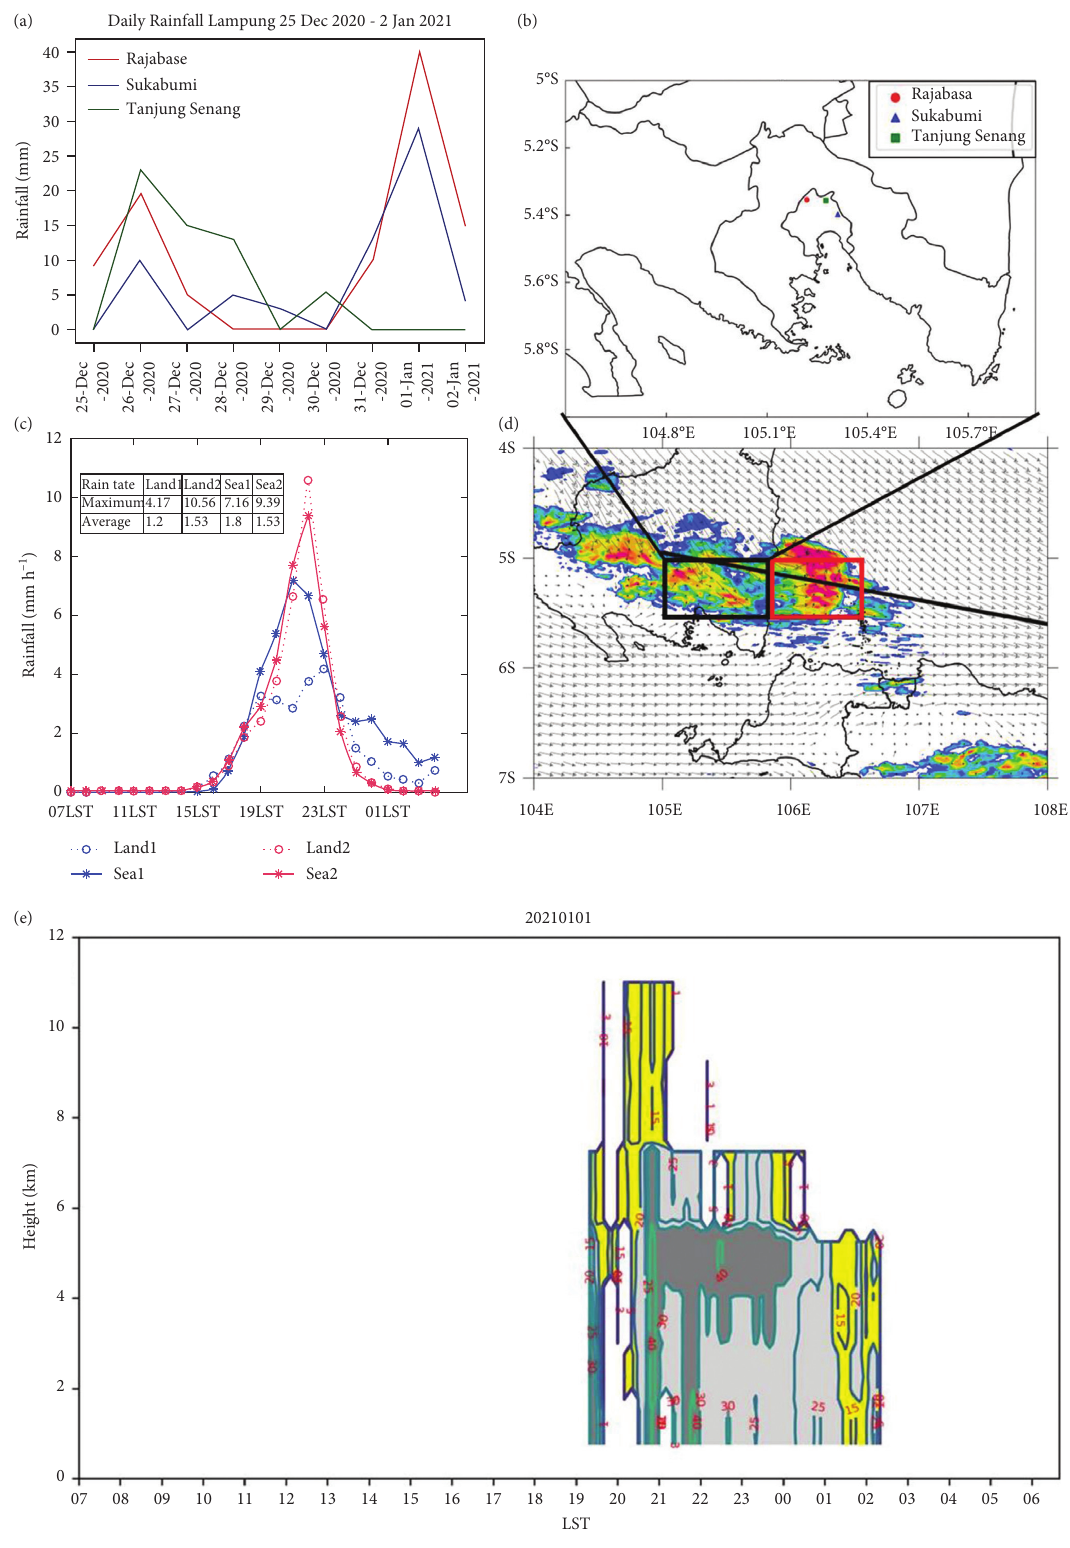
Figure 7: (a) Time series of daily accumulation of rainfall from BMKG station during December 30, 2020–January 2, 2021. (b) A map of the 3 station data locations. (c) Comparison of simulated diurnal rainfall (mm h − 1 ) at D03 (1km) resolution with GSMaP satellite. Rainfall over seaside (landside) from GSMaP (WRF) is denoted as Sea1 (Sea2) and Land1 (Land2), respectively. (d) The landside and seaside area denoted for area averaged over 105–105.8 ° E 5.5–5 ° S (black box) and 105.8–106.5 ° E; 5.5–5 ° S (red box) of the eastern coastal region of South Sumatra. The average diurnal cycle is composited from January 1 to January 2, 2021. (e) Diurnal rainfall observed by radar reflectivity (dBZ) height- time cross section of radar reflectivity (dBZ) over X (105.85 ° E, 5.15 ° S as a center area of Lampung at January 1,